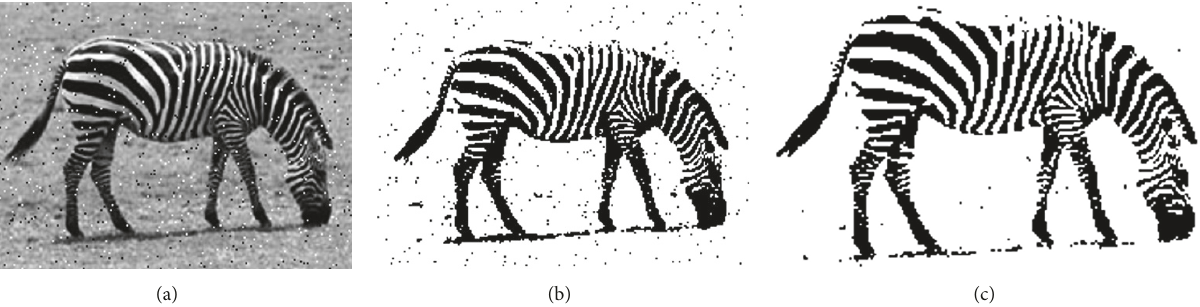
Figure 8: Horse image (0.02-degree encryption salt and pepper noise). (a) Original. (b) The results of one-dimensional Otsu method. (c) The results of our algorithm.